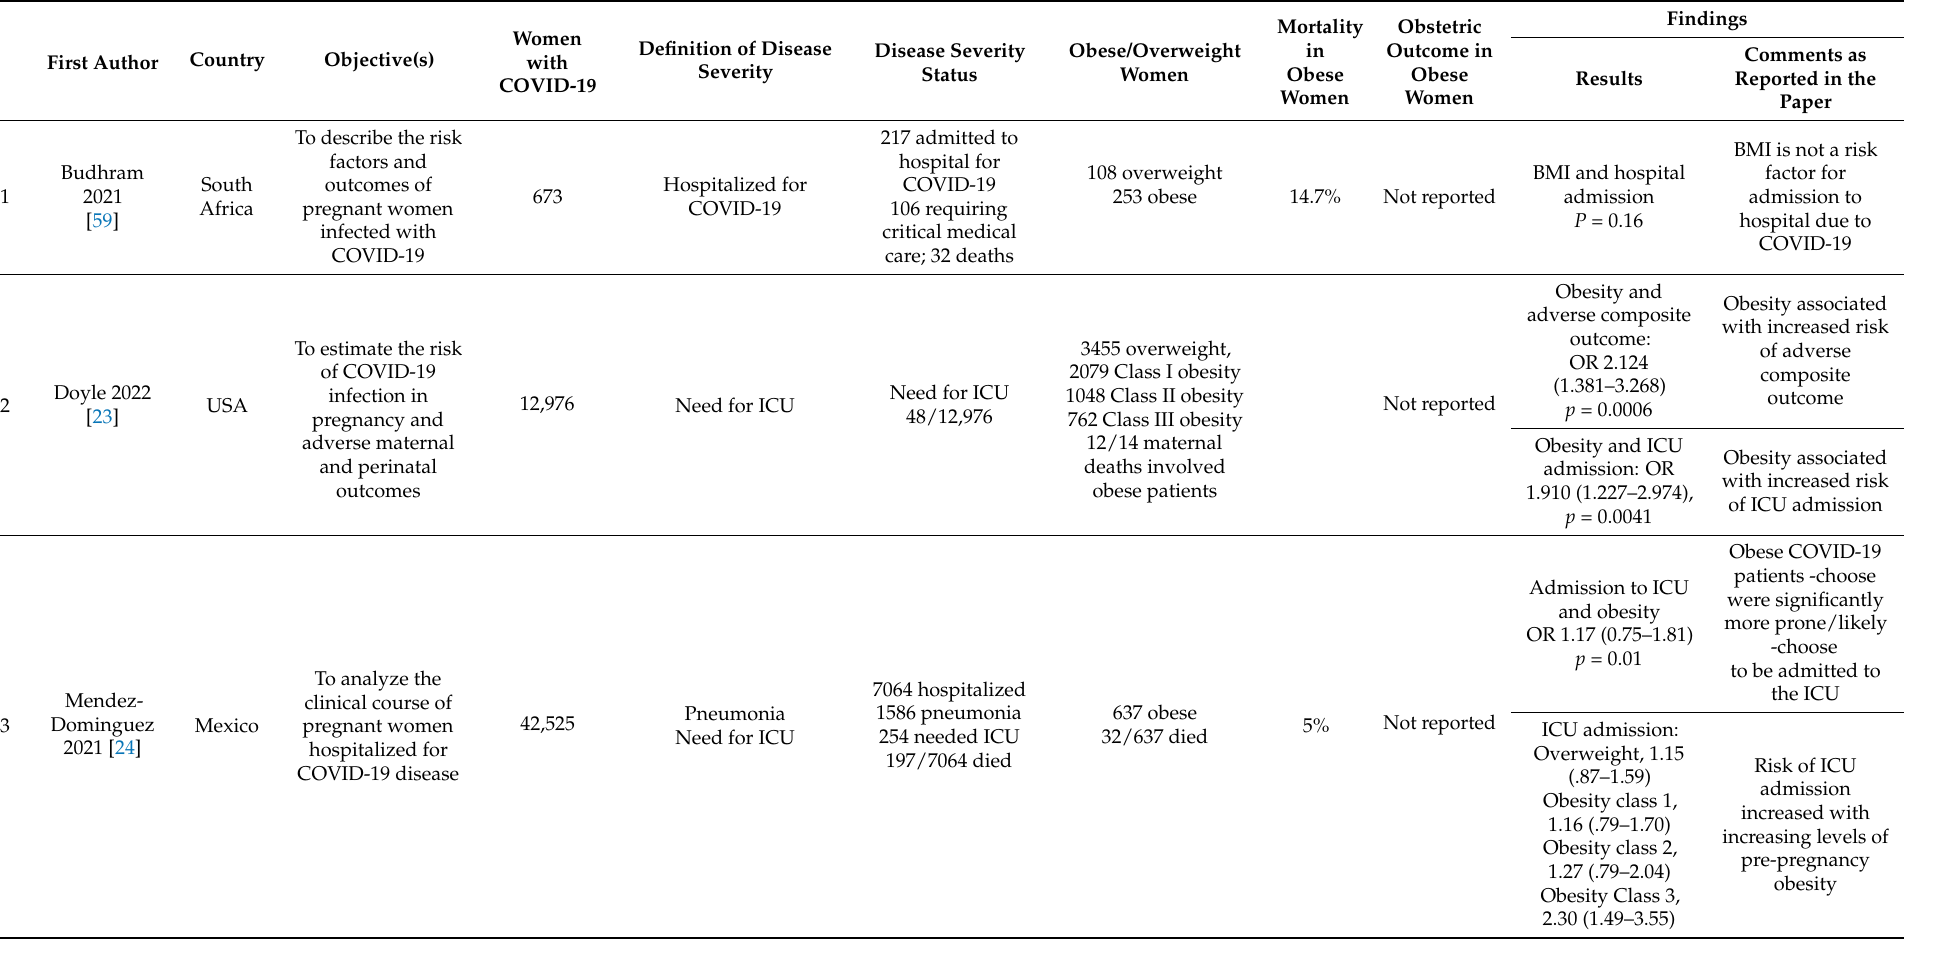
Table 3. Association of overweight/obesity with COVID-19 related hospitalization and Internsive Care Unit (ICU)